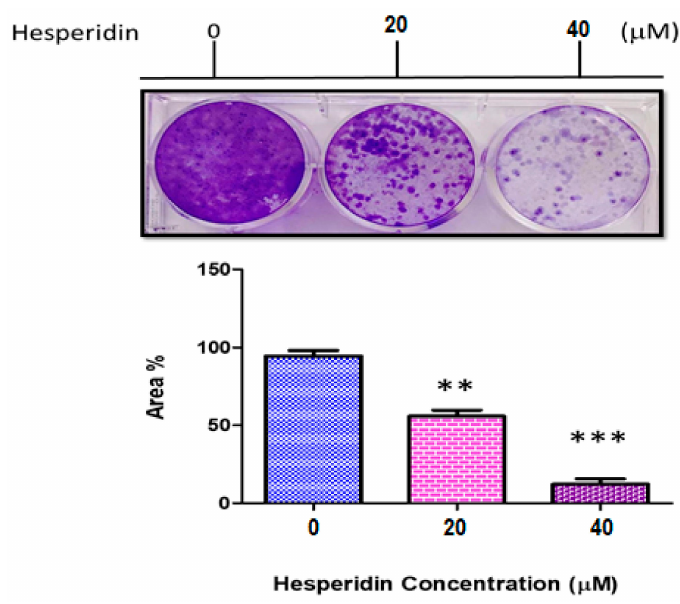
Figure 3. Clonogenity assay of MCF-7 cancer cell line not treated (0), 20, and 40 µ M hesperidin (HSP). ** Significant di ff erences versus control at p < 0.01, *** at p < 0.001. Data represent mean ± SD of three independent experiments, each comprising duplicate cultures.